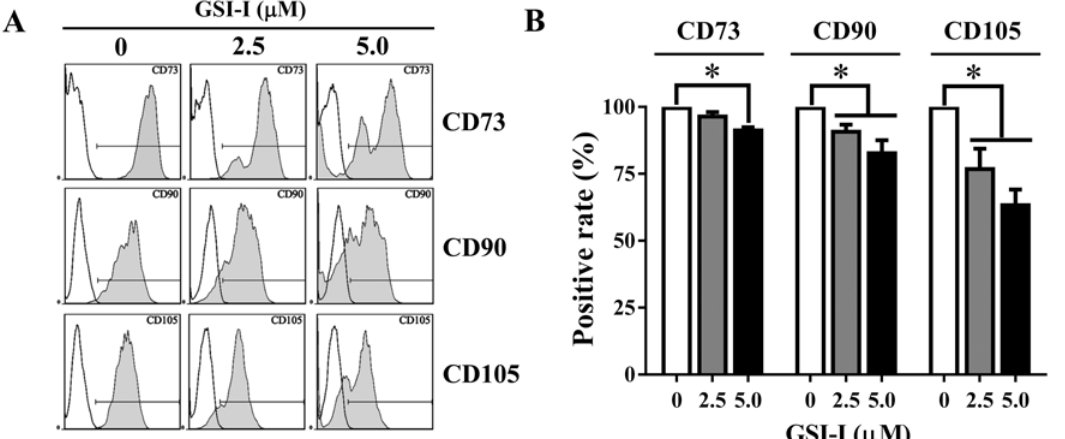
Fig 2. The GSI-I treatment reduces expression of positive MSC surface markers. Representative histogram from a flow cytometry assay shows that, while over 95% untreated hUC-MSCs are positive for CD73, CD90 and CD105 (A), the treatment significantly reduces the positivity for each surface marker with the most significance seen for CD105 reduction. The * indicates the statistical significance with p < 0.05